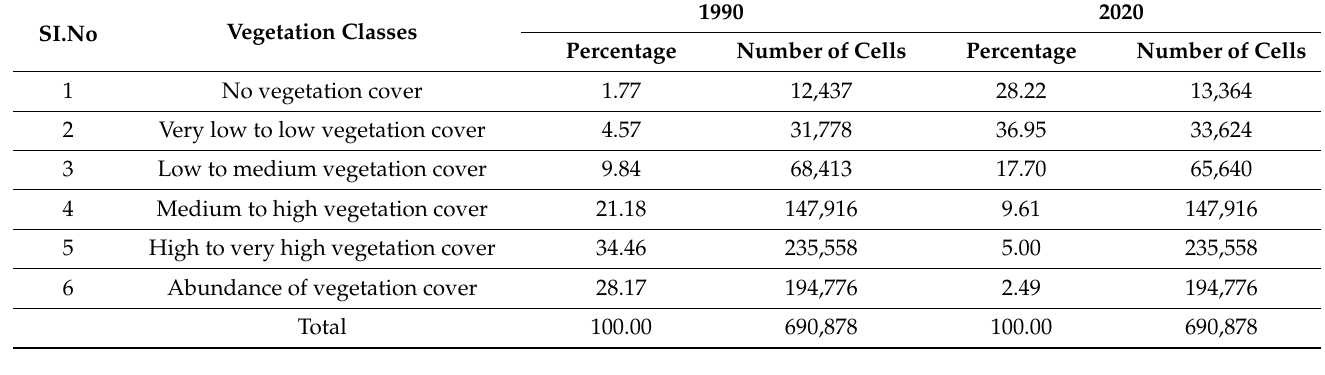
Table 2. The portion and percentage of vegetation index classes in the Tehran metropolis, 1990 and 2020.